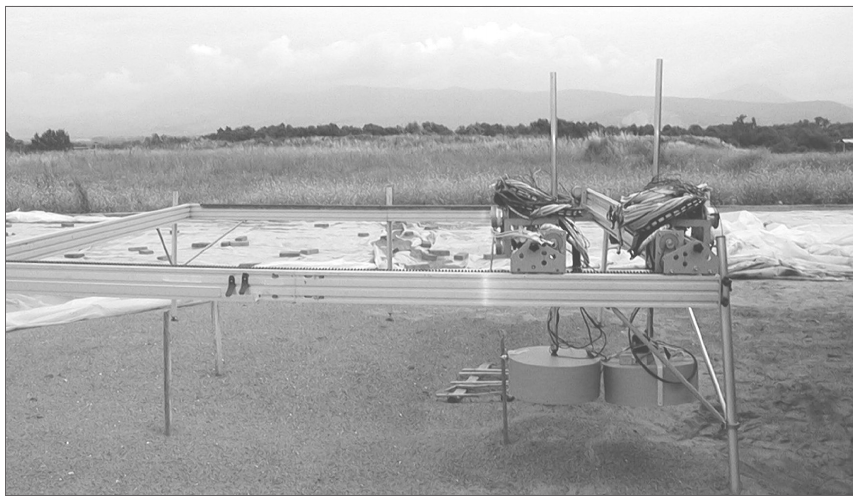
Fig. 2. The antennas positioning system during the campaign on the sand